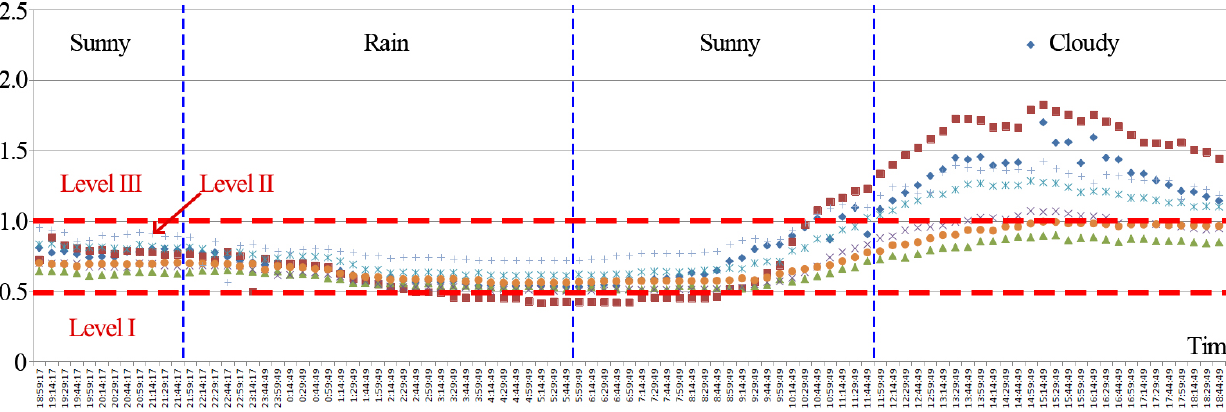
Figure 1. Hot and humid environment APMV change. Table 4. Non-artificial heat- and cold-sourced heat and humidity environment evaluation